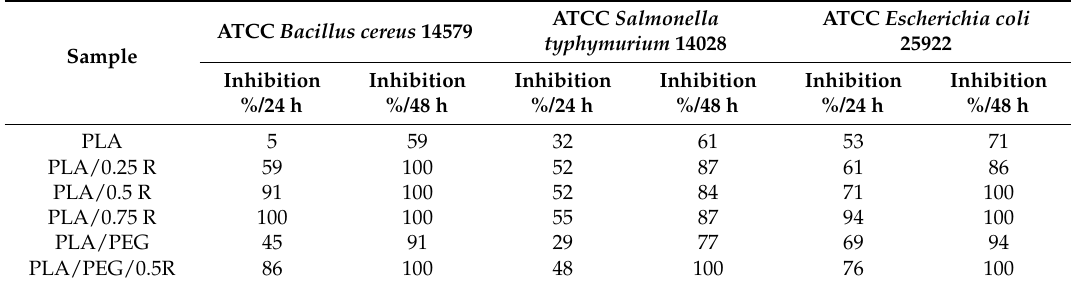
Table 7. Antibacterial activity of the alcoholic extract from rosemary incorporated into